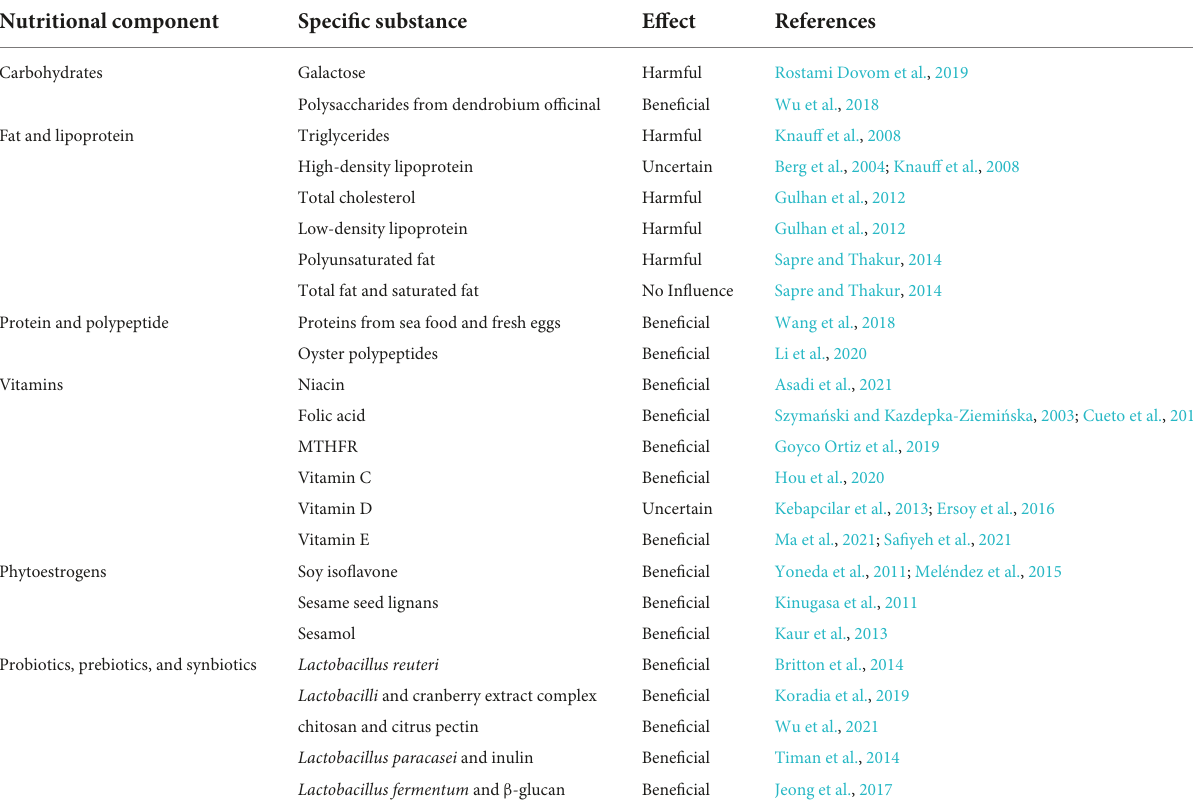
TABLE 1 Representatives from different nutritional components and their potential effects on menopause and